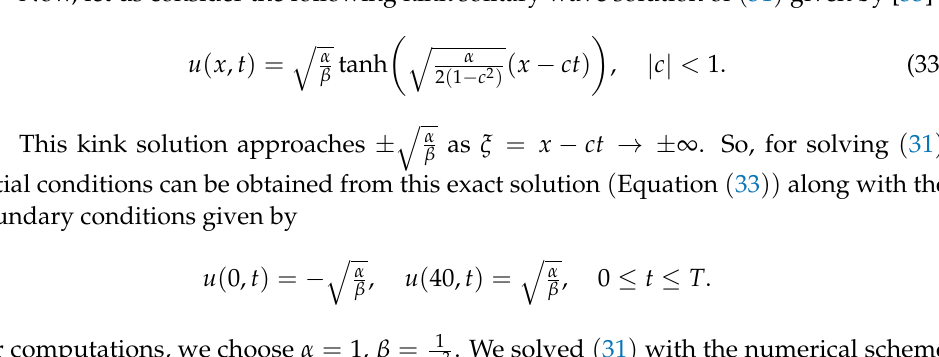
Figure 3. Discrete energy E n and discrete quantities ˜ E n , Q n , and (cid:107) U n scheme ( 6 ) – ( 8 ) with h = τ = 0.1 at time T = 7. E n ( Up-Left ); ˜ E n ( Up-Right ); Q n ( Down-Left ); and (cid:107) U n (cid:107) 2 ( Down-Right t